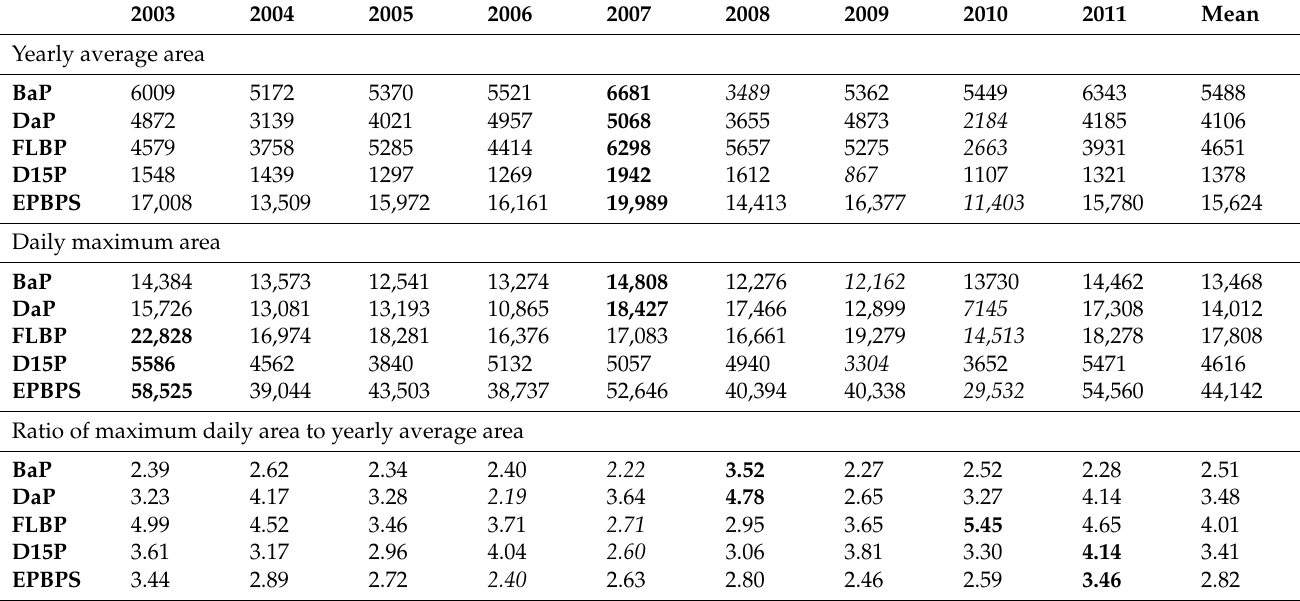
Table 1. Statistical information about the polynya area for each year in eastern Prydz Bay (Unit: km 2 ). The maximum and minimum values are in bold and italics, respectively.